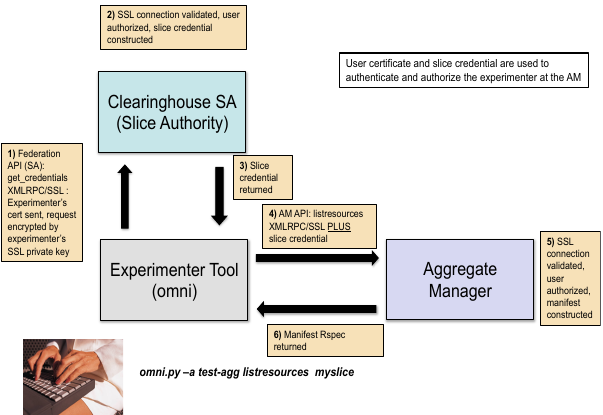
Figure 4. Trust Credentials at Work: Getting a slice credential in a desktop tool context.